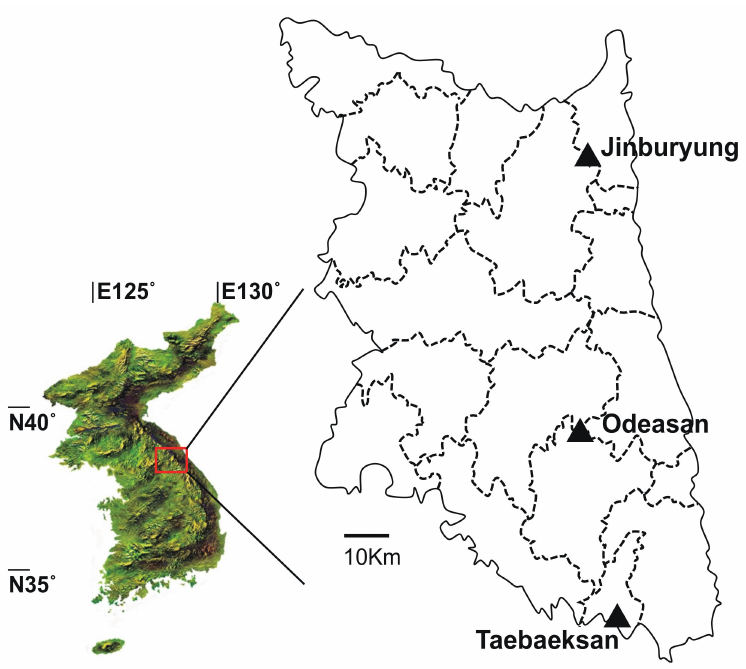
Figure 1. Locations of study sites on the Baekdudaegan Mountain Range,